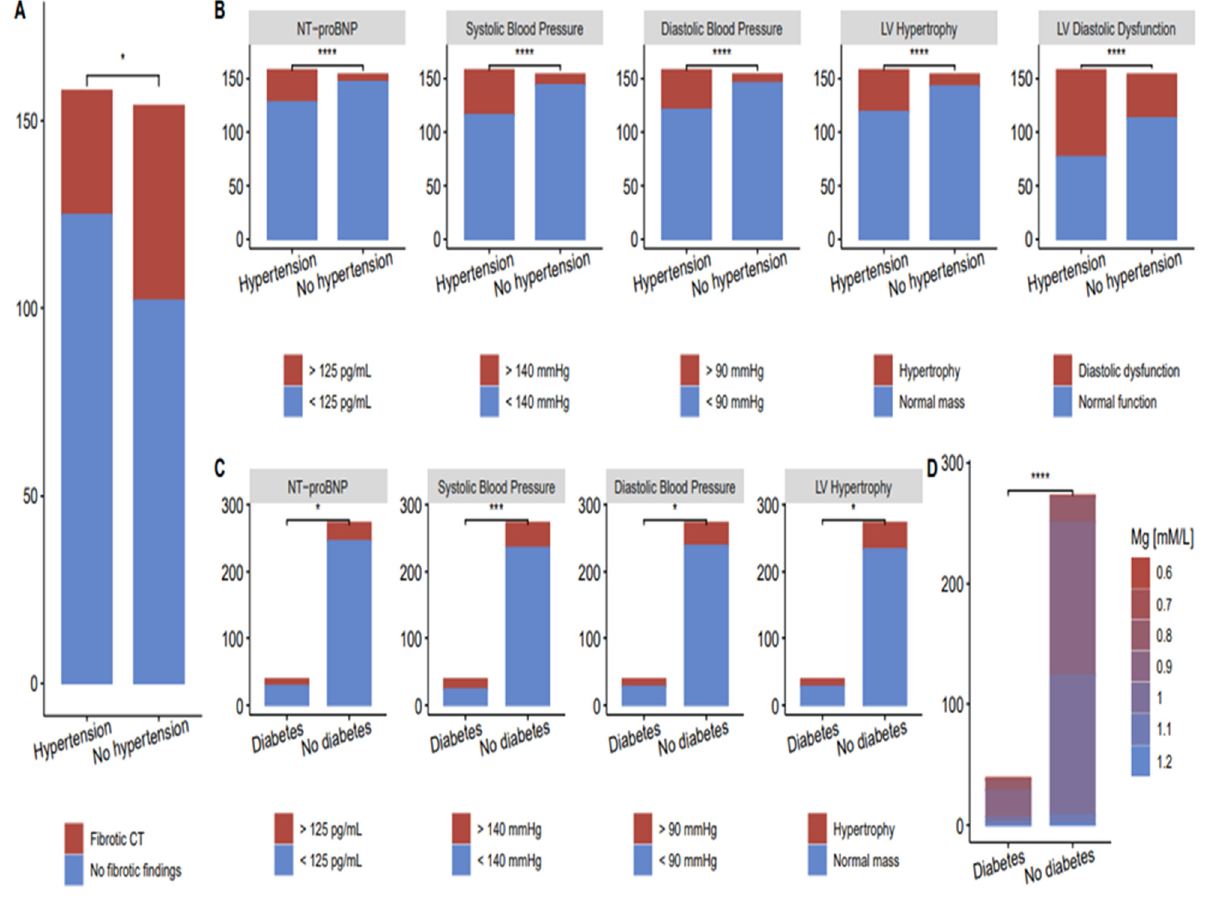
Figure 5. Fibrotic changes and cardiac abnormalities in patients with and without comorbidities. ( A) Fibrotic changes in CT scan of post-COVID-19 patients with and without hypertension; ( B ) Car- diac abnormalities in post-COVID-19 patients with and without hypertension; ( C ) Cardiac abnor- malities in post-COVID-19 patients with and without type 2 diabetes; ( D ) Fibrotic changes in CT scan of post-COVID-19 patients with and without type 2 diabetes (* p < 0.05, *** p < 0.001, **** p < 0.0001).